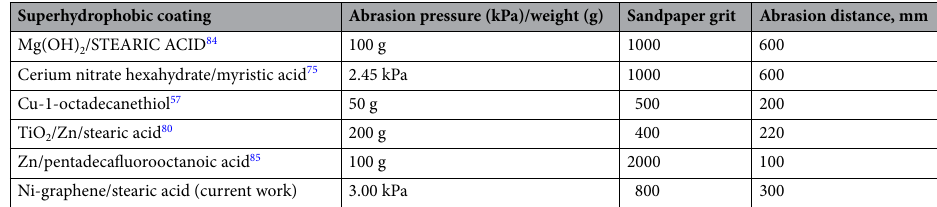
Table 3. Comparison of the of the recently published work on the mechanical abrasion resistance of the superhydrophobic surfaces on the steel substrate with the prepared superhydrophobic surface.